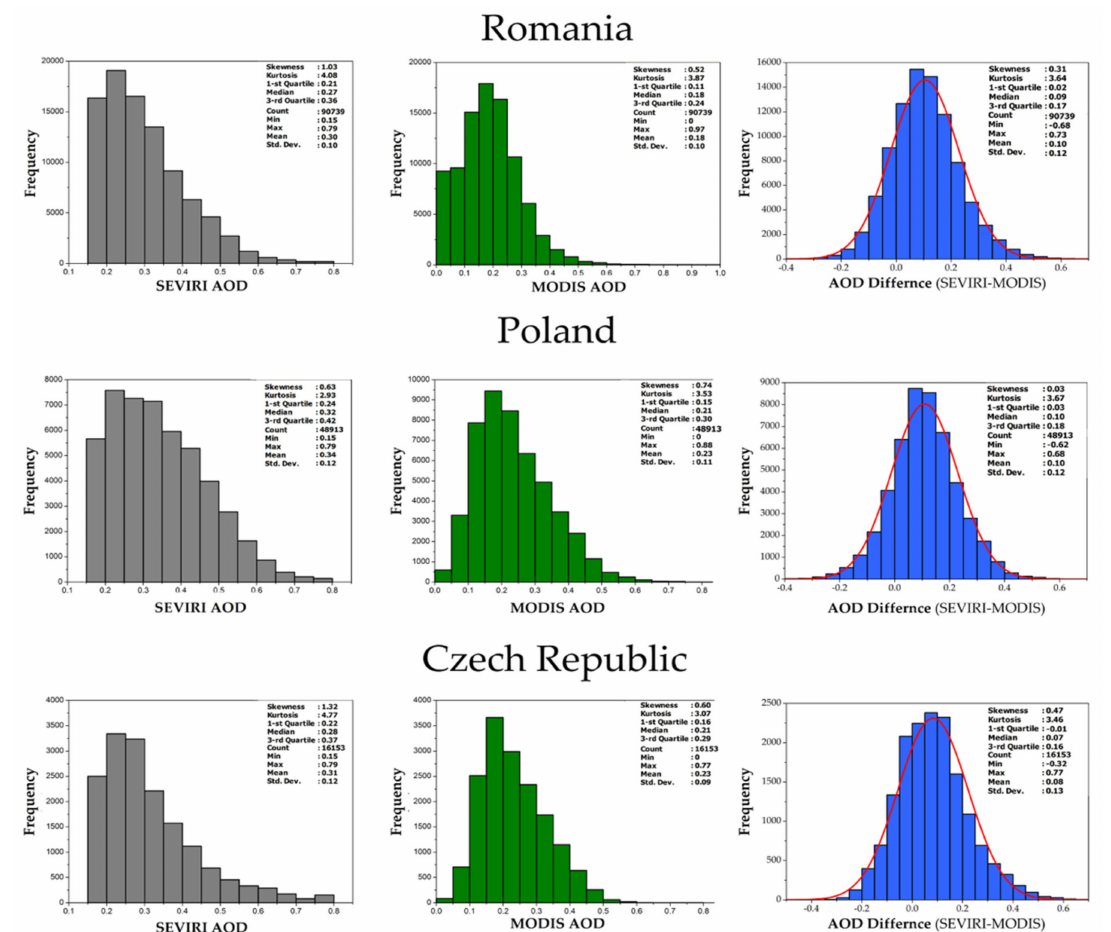
Figure 9. Distribution of SEVIRI AOD (left), MODIS AOD (centre) and AOD differences between SEVIRI and MODIS for Romania, Poland and Czech Republic. Table 8. Comparison between the SEVIRI NRT AOD estimated error [58] and the bias-corrected estimated error.